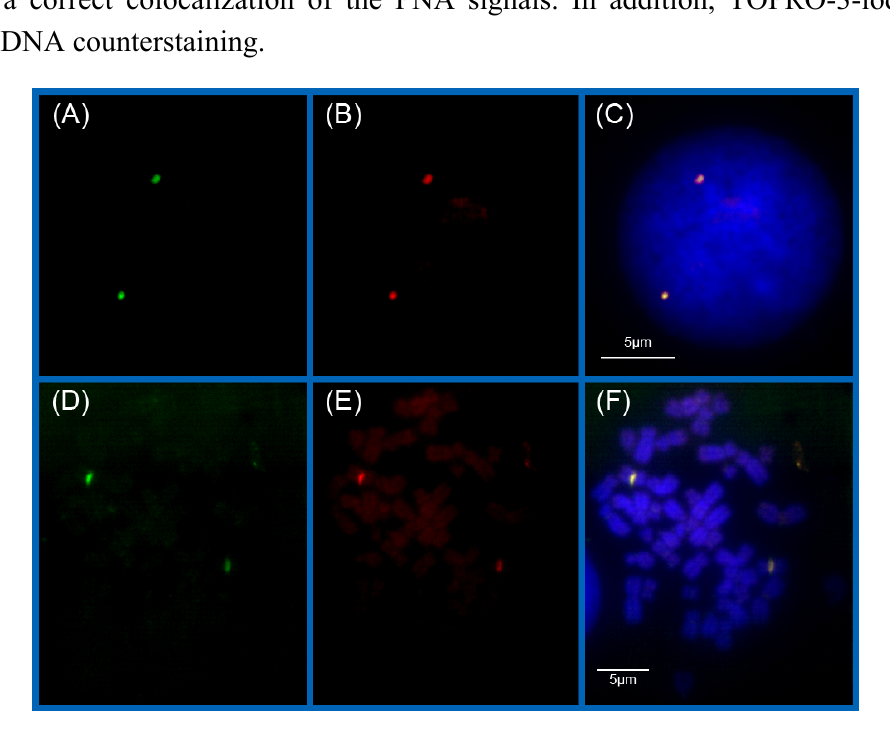
and emission  maxima) ex em